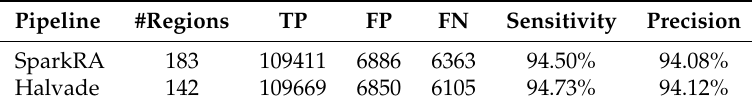
Table 4. Accuracy of VCF files generated by the cluster deployment of SparkRA and Halvade-RNA as compared with the GATK baseline in terms of sensitivity and precision. The comparison results were generated using RTG Tools